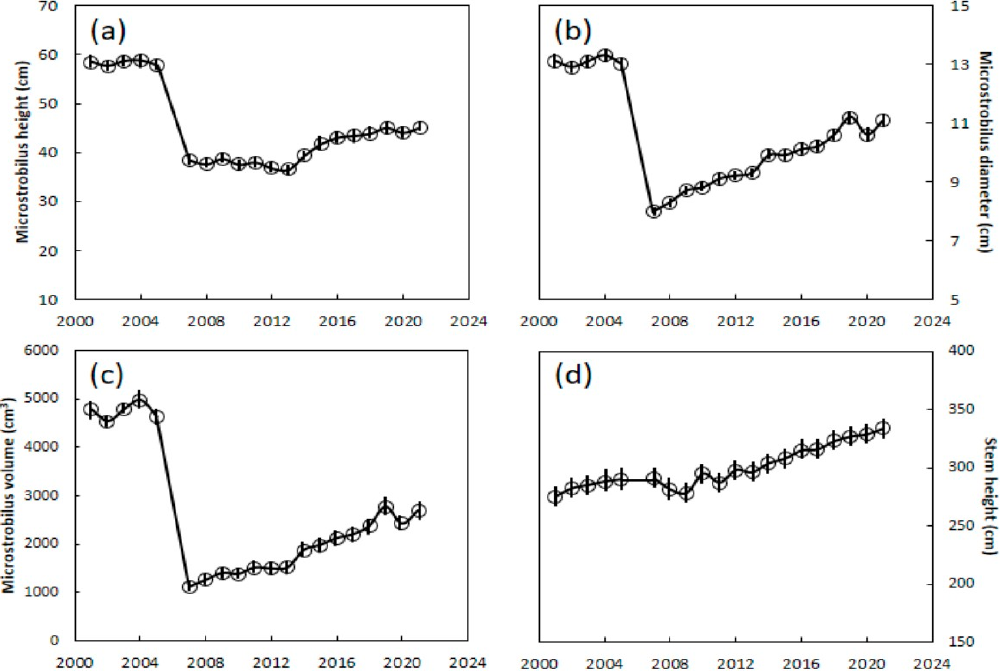
Figure 2. Cycas micronesica stem and microstrobilus size in Guam karst forest from 2001 to 2021. ( a ) Microstrobilus height; ( b ) microstrobilus diameter; ( c ) microstrobilus volume; ( d ) stem height. Mean ± SE, n = 50.